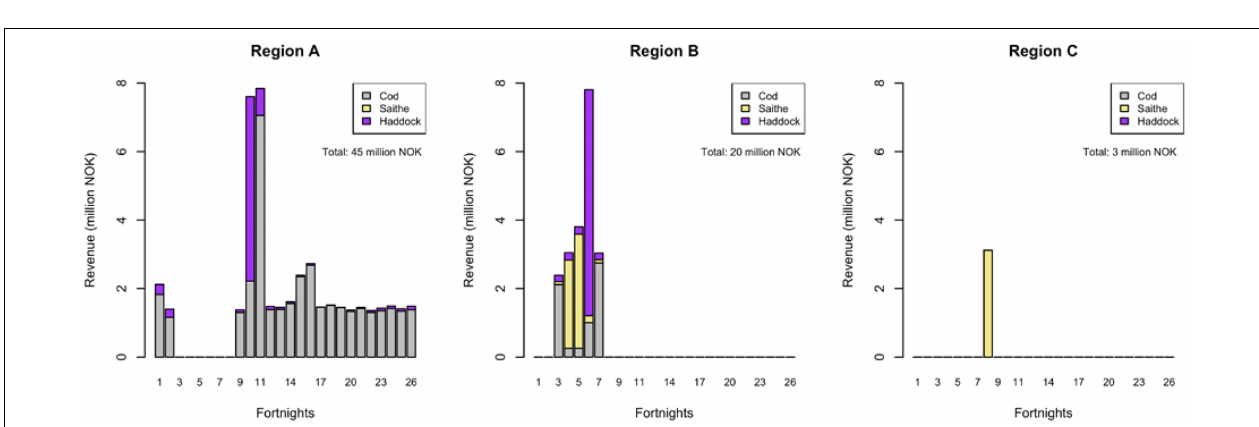
FIGURE 8 | Optimal effort allocation in the cod, saithe, and haddock fisheries in the three selected regions over 26 fortnights.